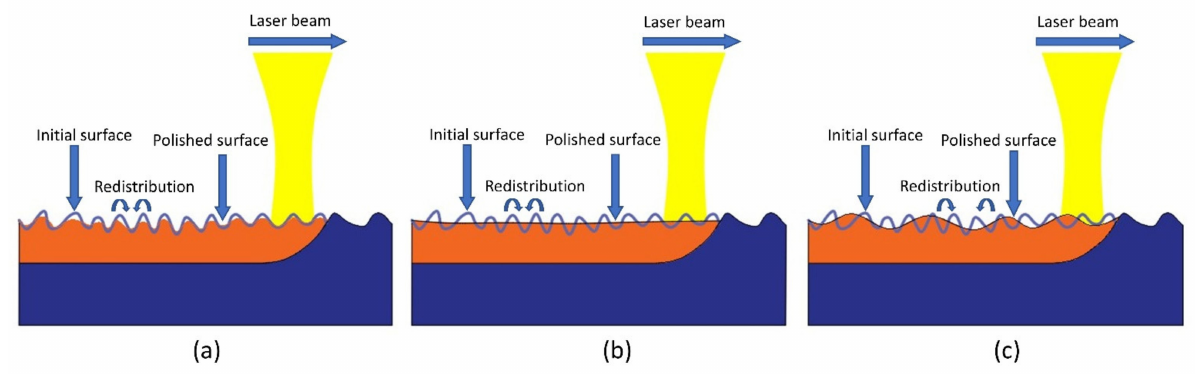
Figure 4. Mechanism diagram of laser polishing: ( a ) incomplete melting; ( b ) shallow surface melting; ( c ) surface